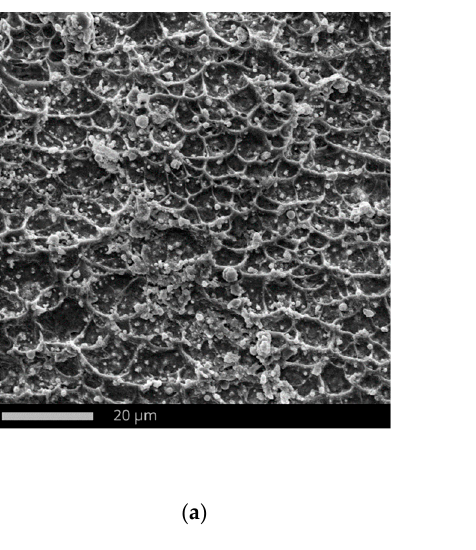
Figure 14. Ductile fracture of the steel plate with lead layer from projectile material at various magnifications: ( a ) × 2750, ( b ) × 1550, ( c ) × 1650, and ( d ) × 2450.